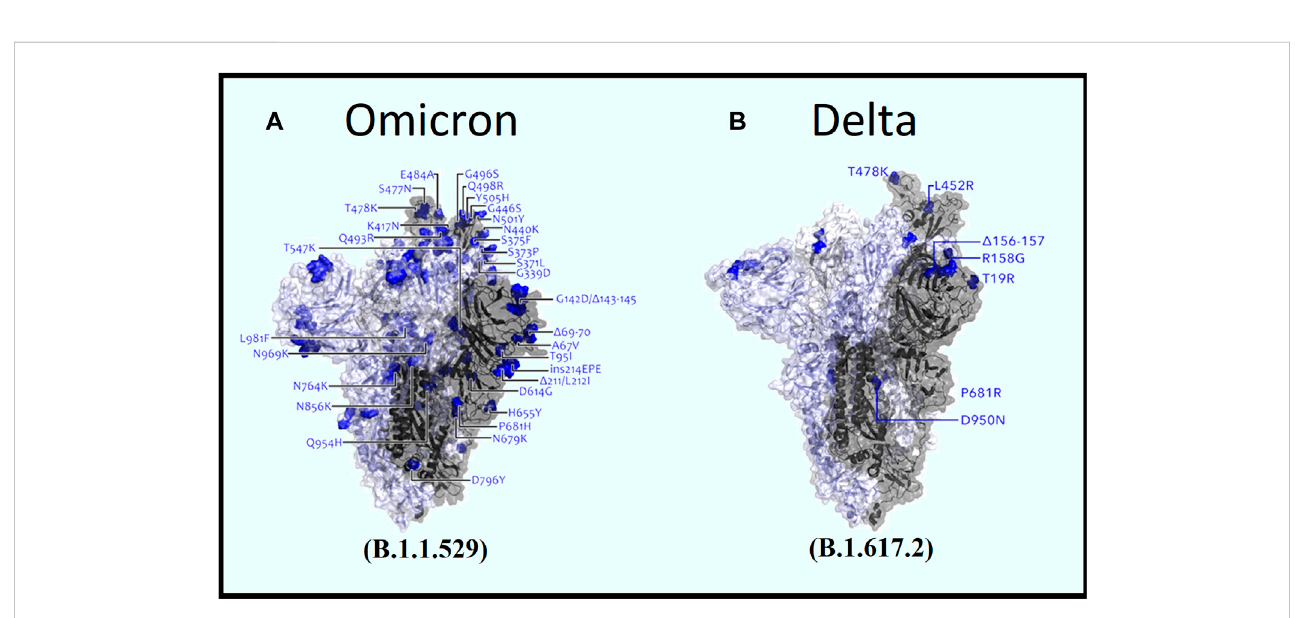
FIGURE 4 Comparative view of spike mutations within (A) Omicron and (B) Delta variants (Image source: Modi fi ed from COG-UK Mutation Explorer: http://sars2.